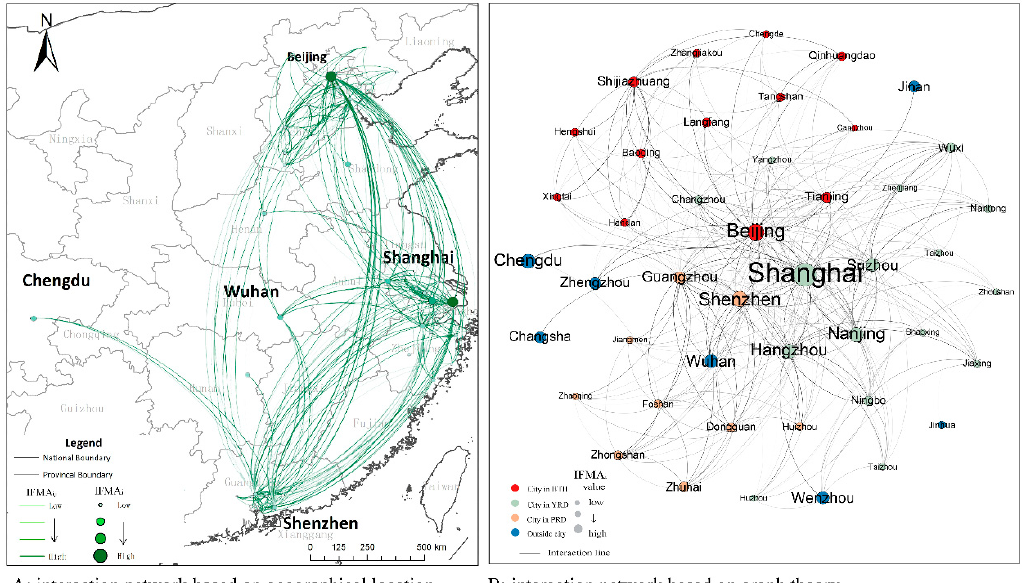
Figure 7. The network of IFMA ij.